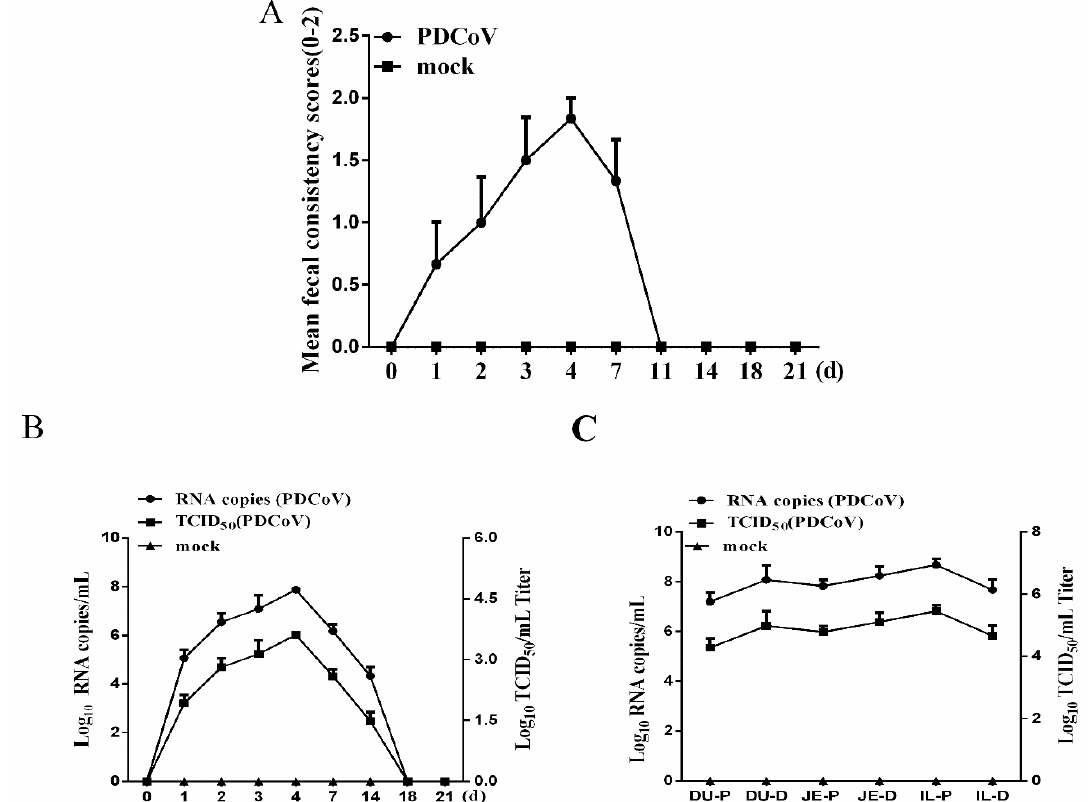
Figure 3. Fecal viral shedding and virus distribution in piglets challenged with PDCoV-JS-2017. ( A ) Diarrhea of piglets in different groups. The severity of diarrhea was scored based on visual examination; 0 = normal and no diarrhea; 1 = mild and fluidic diarrhea; 2 = severe watery diarrhea; scores of 1 or more were considered diarrheic. ( B ) Fecal virus shedding in PDCoV-challenged piglets. ( C ) Virus distribution in the small intestine of piglets challenged with PDCoV. DU-P: Duodenum proximal. DU-D: Duodenum distal. JE-P: jejunum proximal. JE-D: jejunum distal. IL-P: ileum proximal. IL-D: ileum distal.